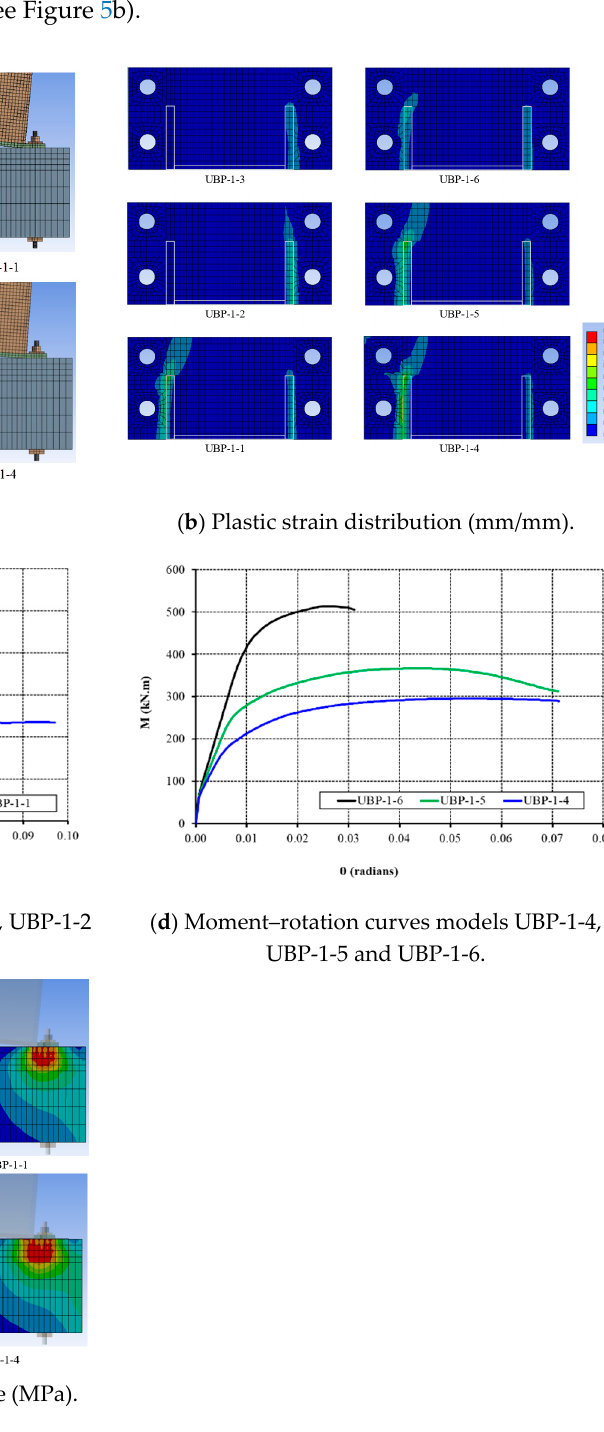
Figure 5. Influence of base-plate thickness model UBP-1.